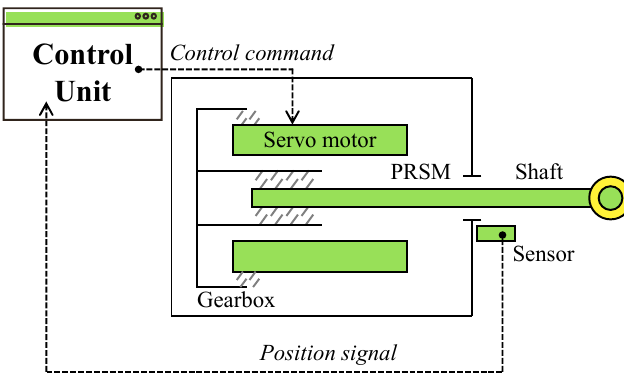
Figure 1. Schematic diagram of an EMA.